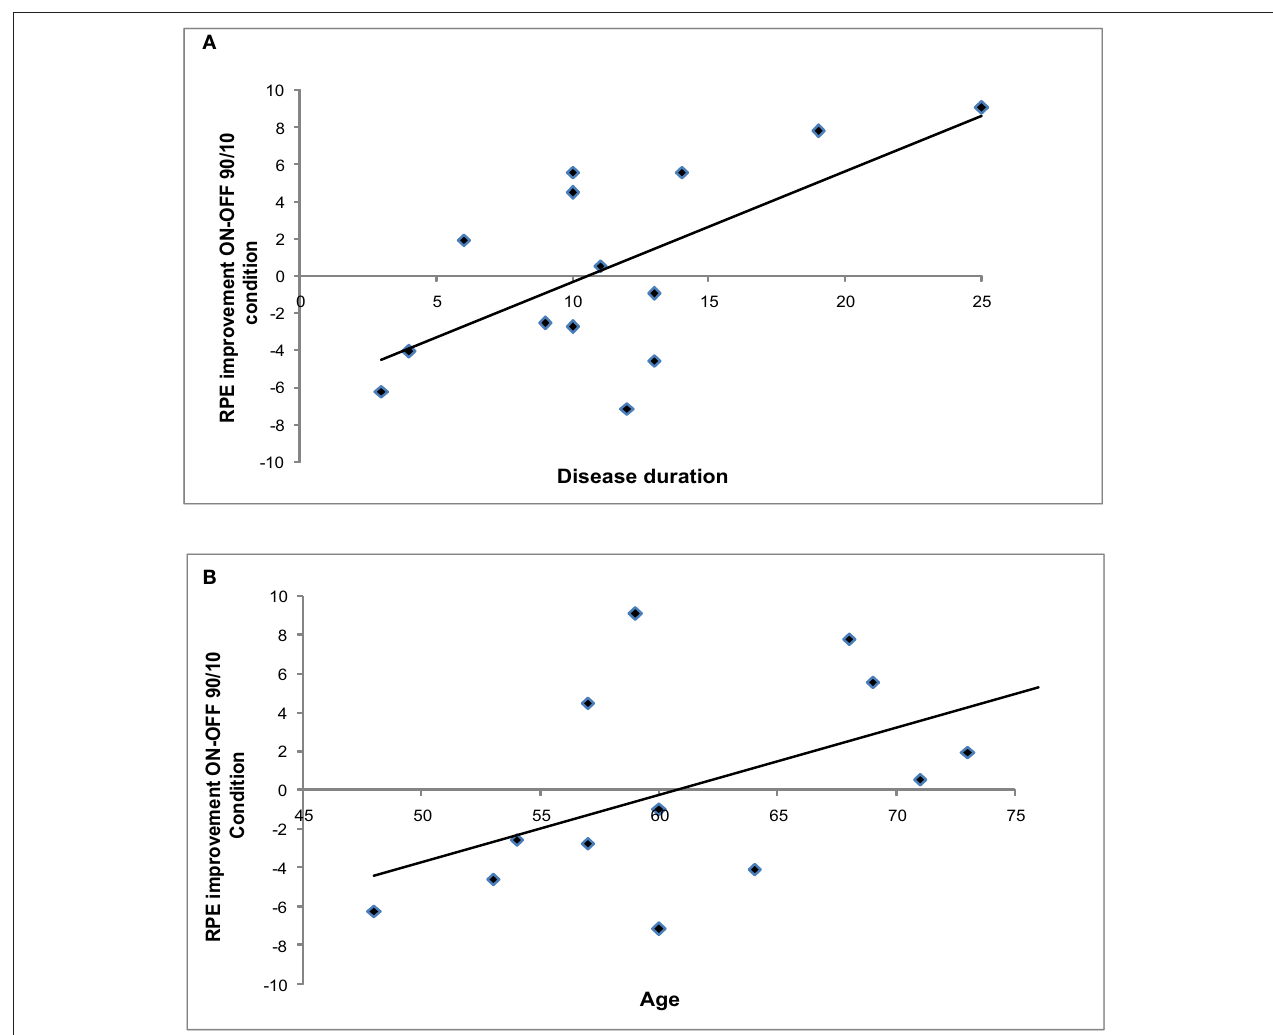
Figure 5 | (A) ∆ RPE (ON–OFF) in the 90/10 Condition as a function of disease duration. (B) ∆ RPE (ON–OFF) in the 90/10 Condition as a function of